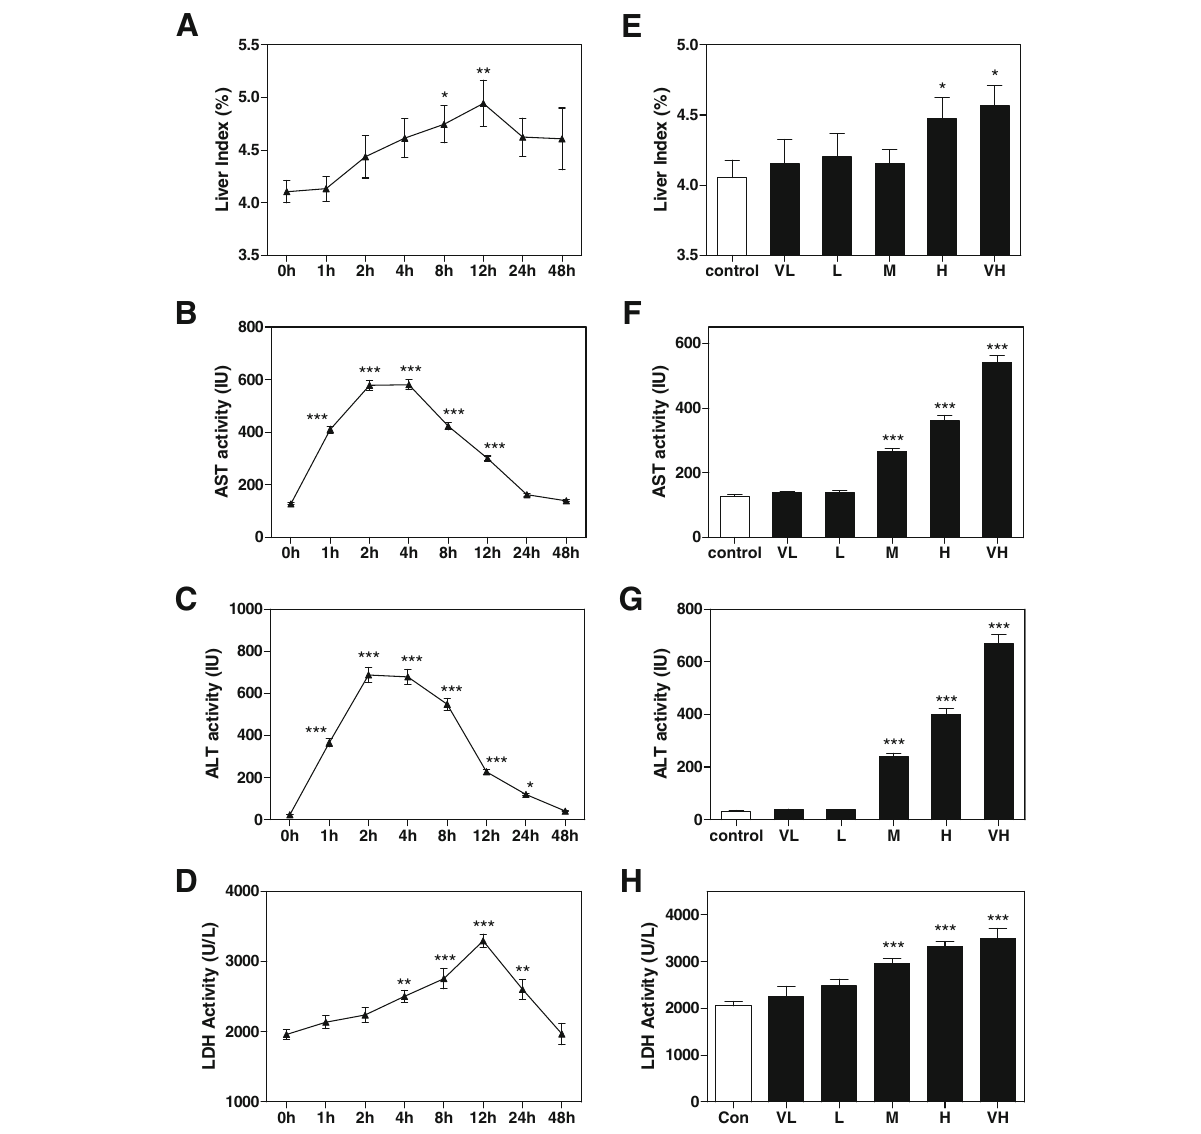
Fig. 2 SS-induced liver toxicity. a and e liver index, Serum level of b and f AST, c and g ALT and d and h LDH after different time and dose of SS administration. All the data are presented as mean ± S.E. ( n = 8), * p < 0.05 , **p < 0.01 , ***p < 0.001 , compared to time 0 h or vehicle control group,